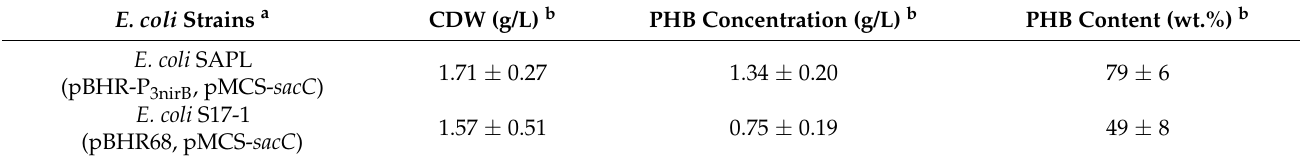
Table 3. Bacterial growth and PHB production by E. coli SAPL (pBHR-P3nirB, pMCS- sacC ) and E. coli S17-1 (pBHR68, pMCS- sacC ) using sucrose as a carbon source under microaerobic conditions.